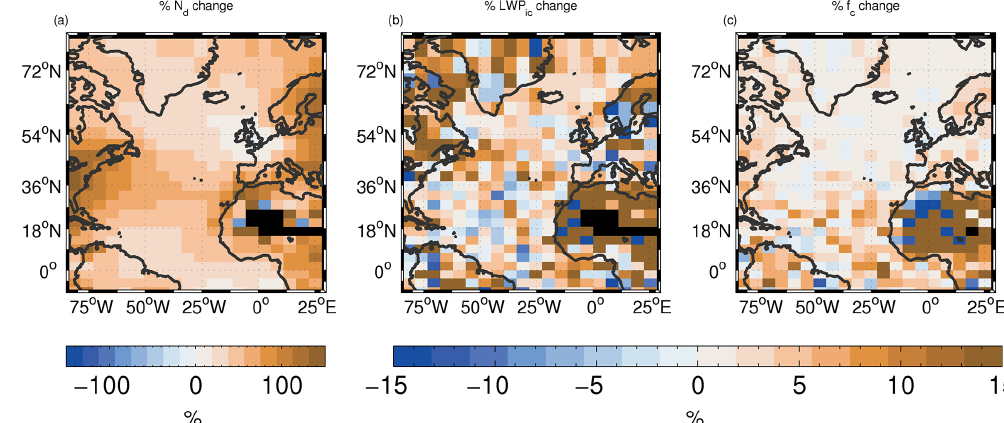
Figure 13. Mean percentage increase in N d , LWP ic and f c between PI and PD runs.